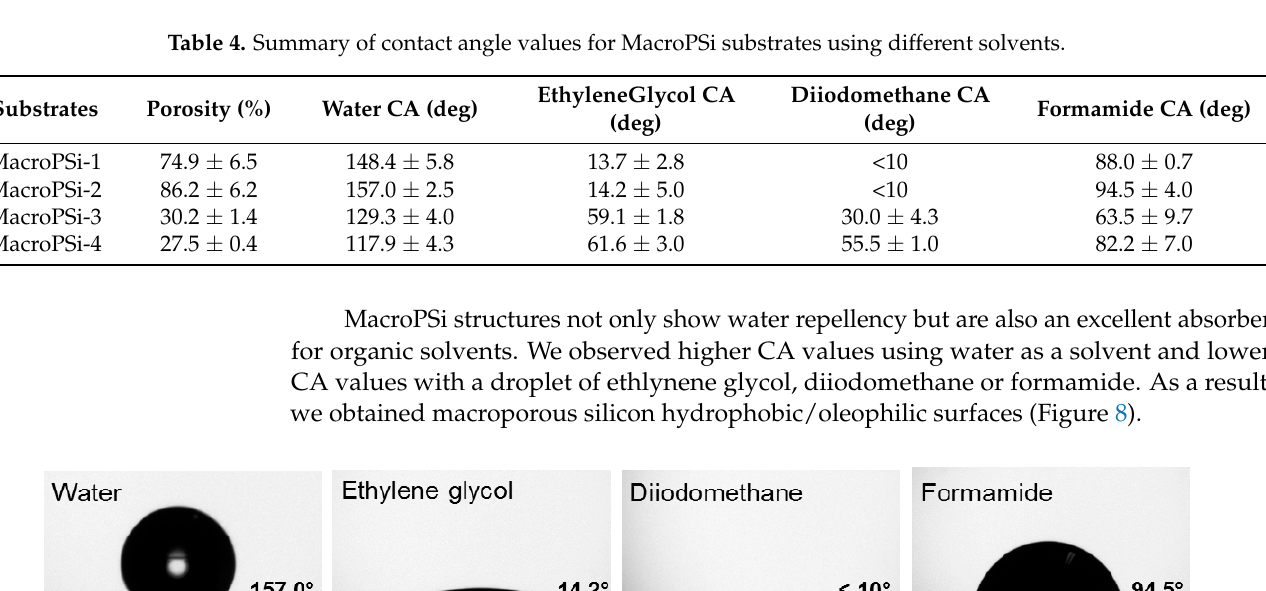
Table 4. Summary of contact angle values for MacroPSi substrates using different solvents. Substrates